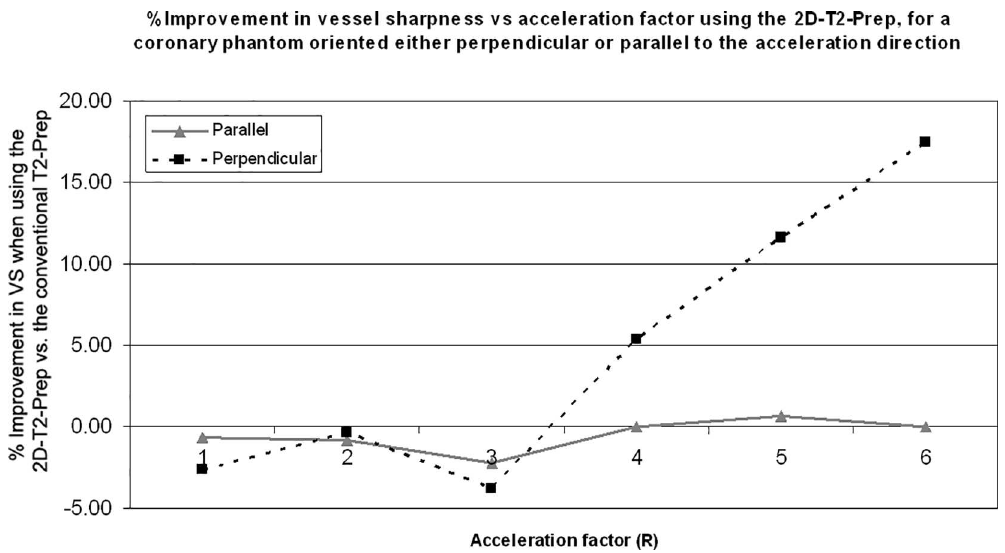
Fig 5. Improvement in the mean vessel sharpness, as measuredin a coronary-mimicking phantom, when using a 2D-T 2 -Prep instead of a conventional T 2 -Prep, for GRAPPA accelerations of R = 1,2,3,4,5, and 6. Results are shown for a "vessel" section a) parallelto the accelerateddirection (gray triangles) and b) perpendicular to the accelerated direction (black squares). As artefacts propagate along the accelerateddirection, the parallelcase acts as a vessel sharpness control, whereas the perpendicular case may be used to determine the relative benefit of the 2D-T 2